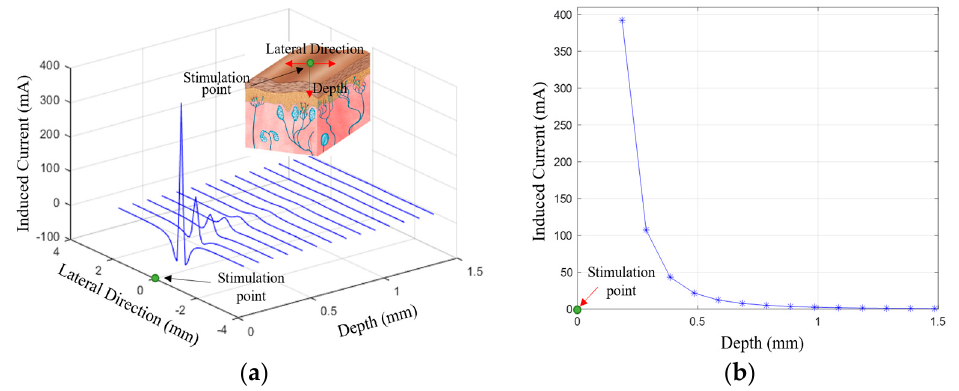
Figure 6. Simulation of electrical signals induced in the skin: ( a ) Simulation results of the magnitude and shape of the induced current by depth and lateral direction from stimulation points in the skin. ( b ) Change of the maximum peak value of induced current according to depth.